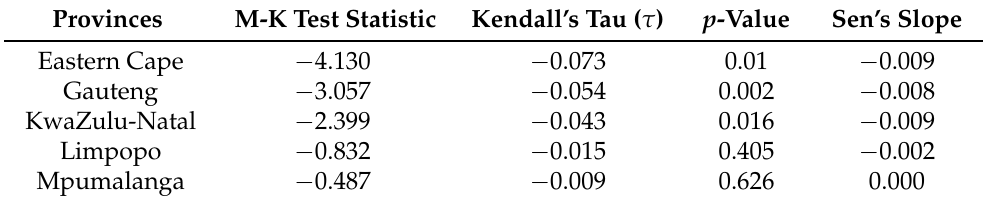
Table 4. Results for Mann-Kendall test statistic and Sen’s slope